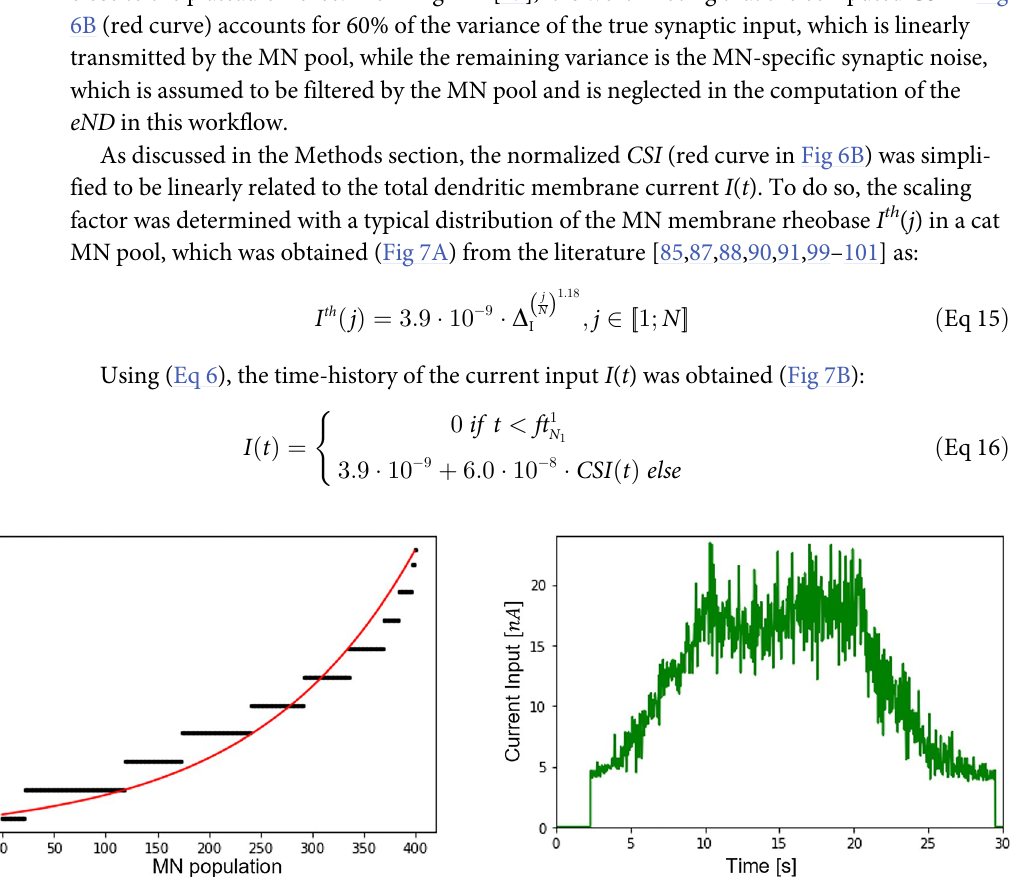
Fig 7. (A) Typical distribution of MN current recruitment threshold I th (N i ) in a cat MN pool according to the literature. (B) Current input I(t), taken as a non-continuous linear transformation of the common synaptic input (red curve in Fig 6B) for the dataset DTA 35